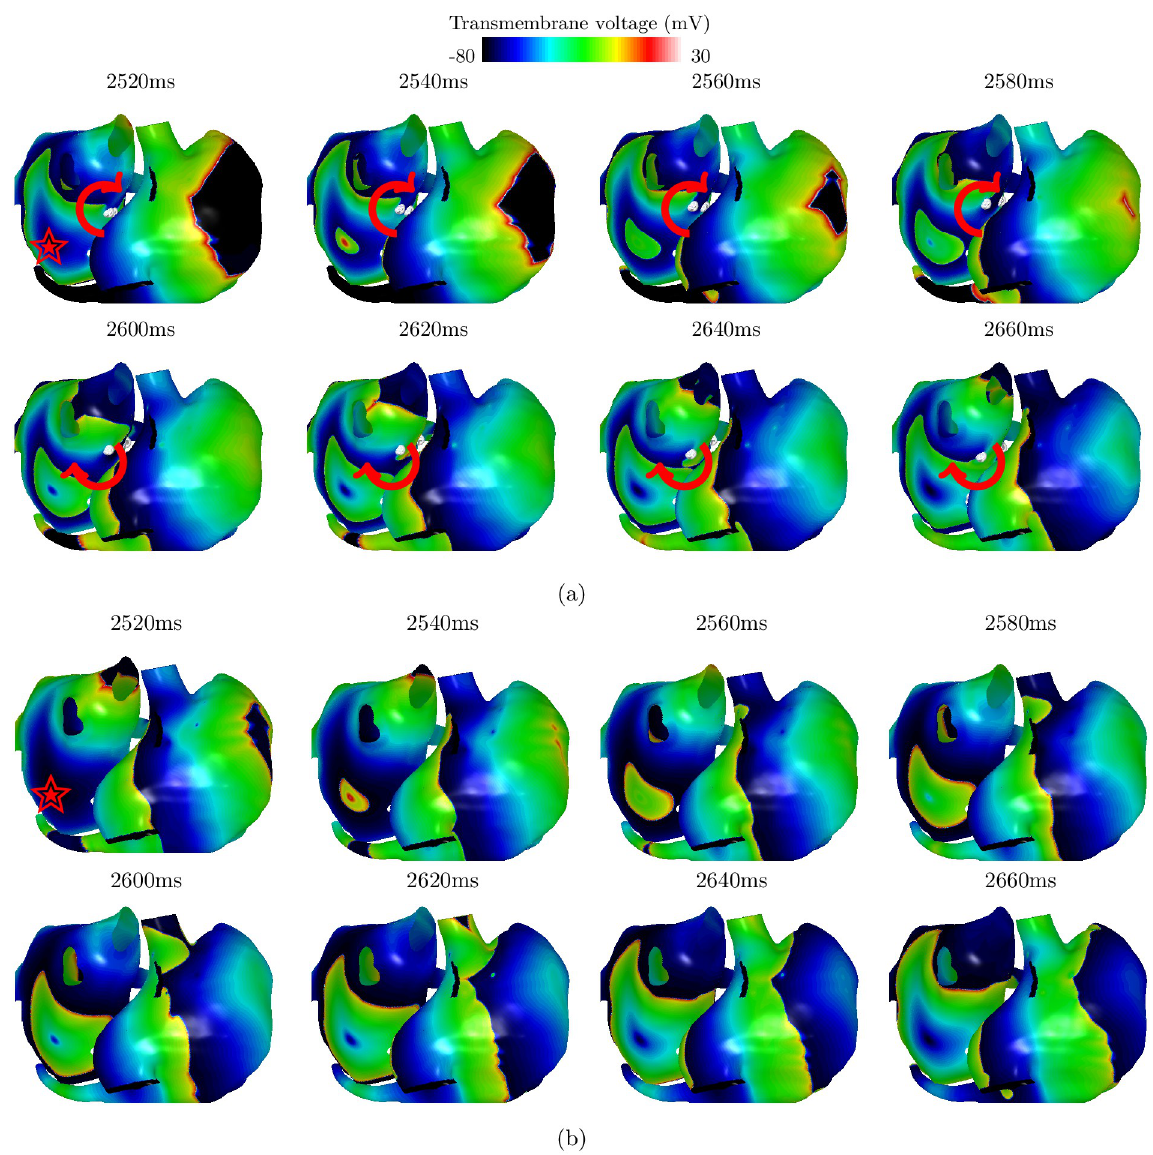
Fig 3. Simulations on the atrial mesh of Patient 2 of (a) an initiator-type FS with a CL of 180 ms at an LA focal site ( α red star), and (b) a driver-type FS with a CL of 210 ms at the same site (red star), with full videos (S1 and S2 Videos). The white spheres in (a) show phase singularity points, and the red arrows show the wavefront movement of rotors. The time since the first firing of the FS was indicated above each frame. A sustained rotor of total duration 547 ms was presented in (a), but no rotor was detected in